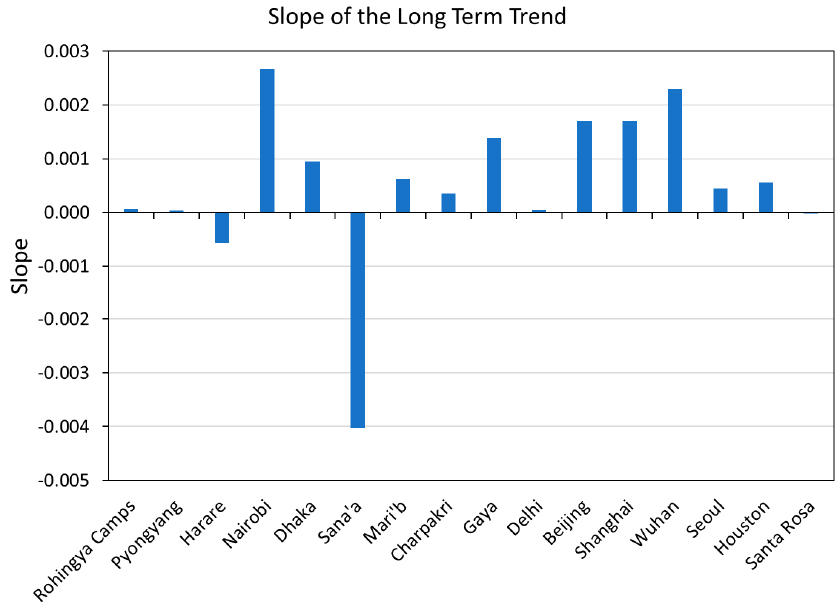
Figure 37. Picket-fence chart of the mean slope of the long-term trend for each of the test sites. Index of dispersion: This index is calculated by dividing the variance by the mean. The theory is that if the brightness of the lighting is fluctuating due to instability in the power supply, the dispersion will be anomalously high. Figure 38 shows a histogram and scattergram of the dispersion. The overall pattern is that the dispersion is tracking the mean. That is to say, as the mean increases, the variance increases even more, and the dispersion level rises. The classification accuracy for dispersion is 58%. Adding in population (lighting per person), the classification accuracy climbs to a